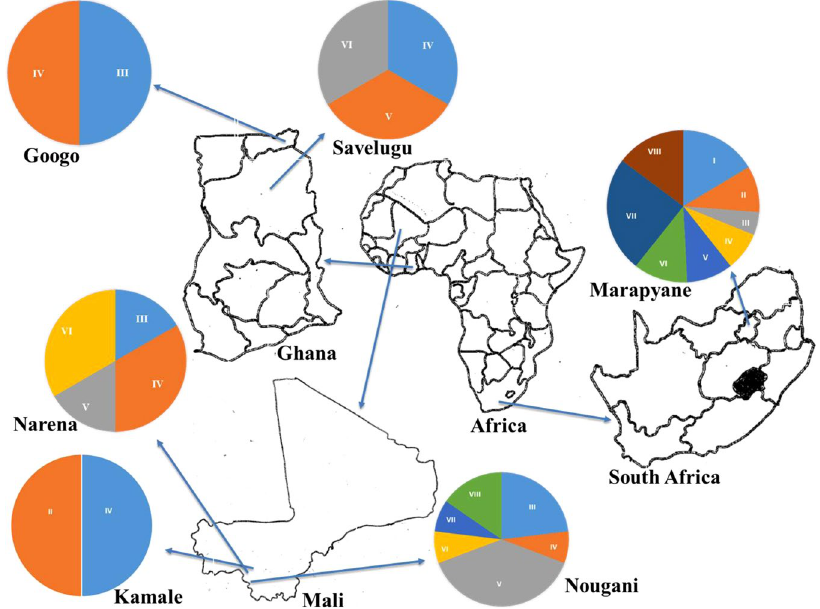
clusters (see Fig. 3). The area of each segment is proportional to the number of isolates from a given location occupying that